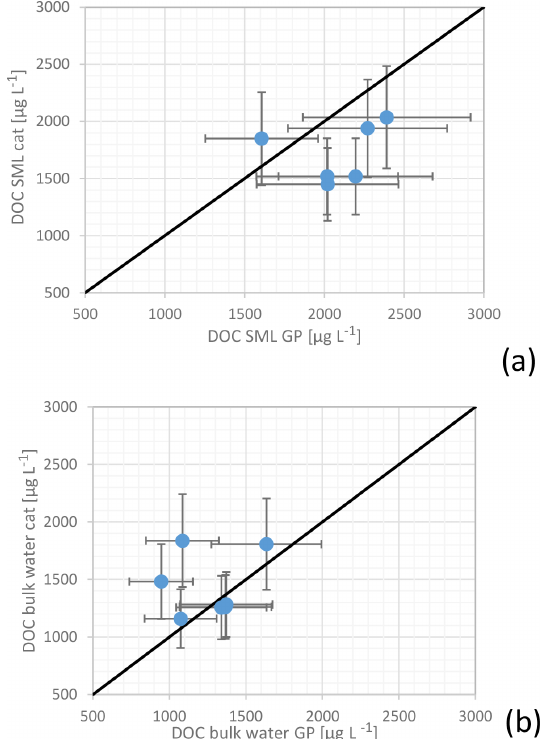
Figure 15. (a) Concentrations of DOC in the SML and (b) and in the bulk water sampled for paired glass plate (GP) and the MarParCat (cat) sampling